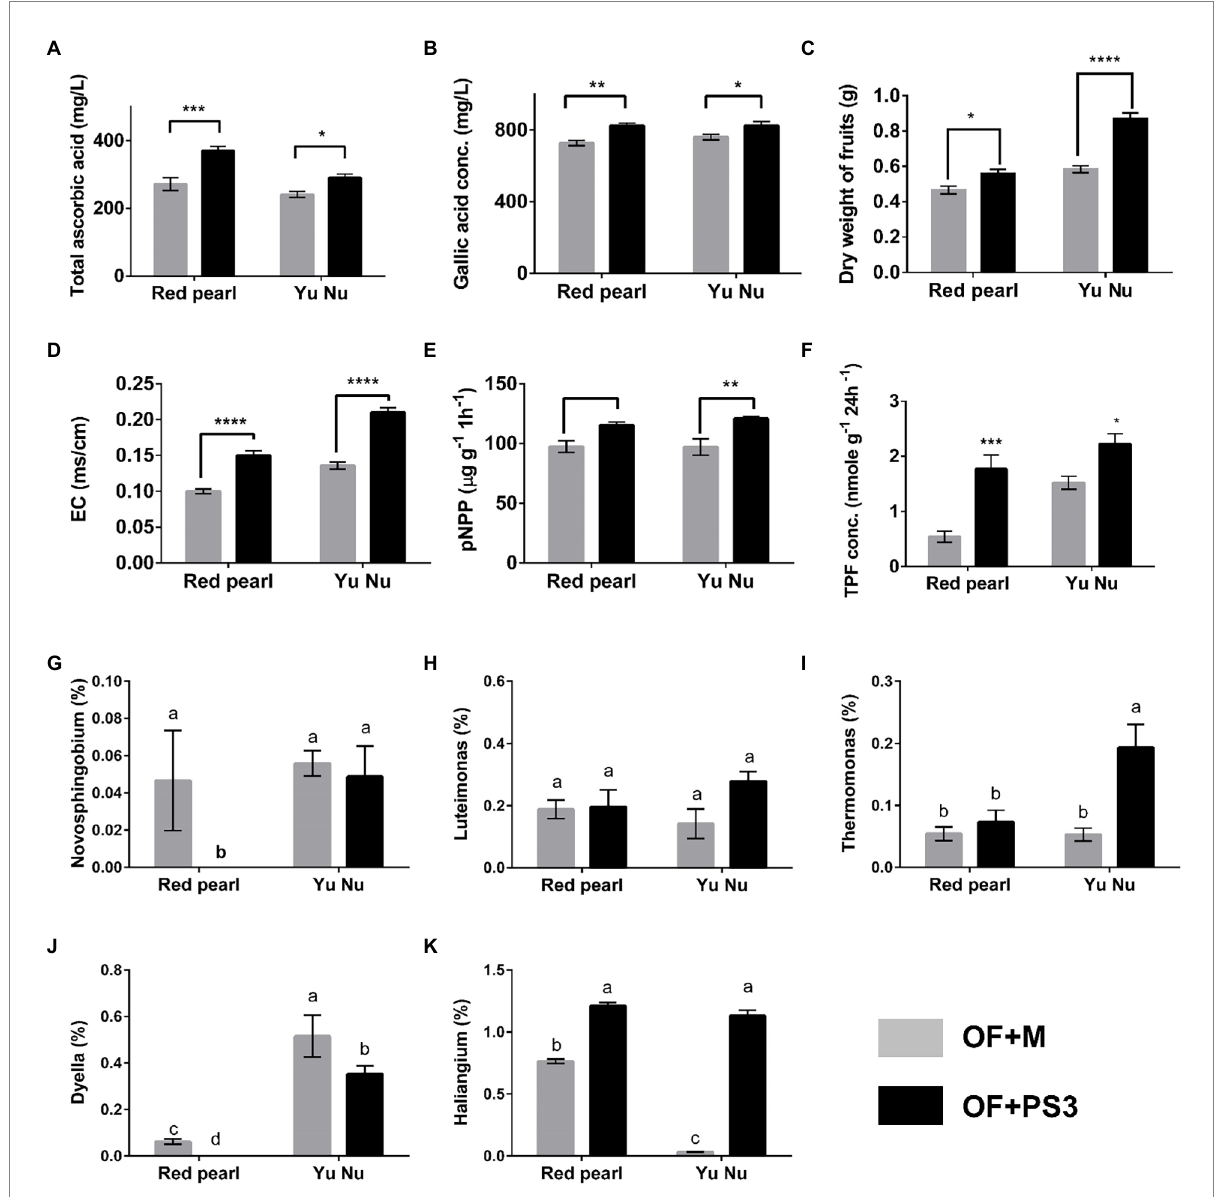
FIGURE 8 Verifying the selected parameters and potential genera by pot experiments with two tomato cultivars (Red pearl and Yu Nu) and soil collected from the aforementioned organic field. (A) total ascorbic acid (vitamin C content); (B) gallic acid concentration (total phenolic content); (C) dry weight of fruits; (D) soil electroconductivity (EC); (E) p-NPP concentration (soil phosphatase activity); (F) TPF concentration (soil dehydrogenase activity); Relative abundances of (G) Novosphingobium (%); (H) Luteimonas (%); (I) Thermomonas (%); (J) Dyella (%); and (K) Haliangium (%). Data are expressed as the mean ± SE. The statistical test was based on Welch’s t-test for panels (A–F) (ns, p > 0.05,* p < 0.05, ** p < 0.01, *** p < 0.005, and **** p < 0.001) and one-way ANOVA followed by Tukey’s post hoc test for panels (G–K) (letters above means indicate significant differences among treatments at a threshold of p < 0.05). Each treatment consisted of five biological